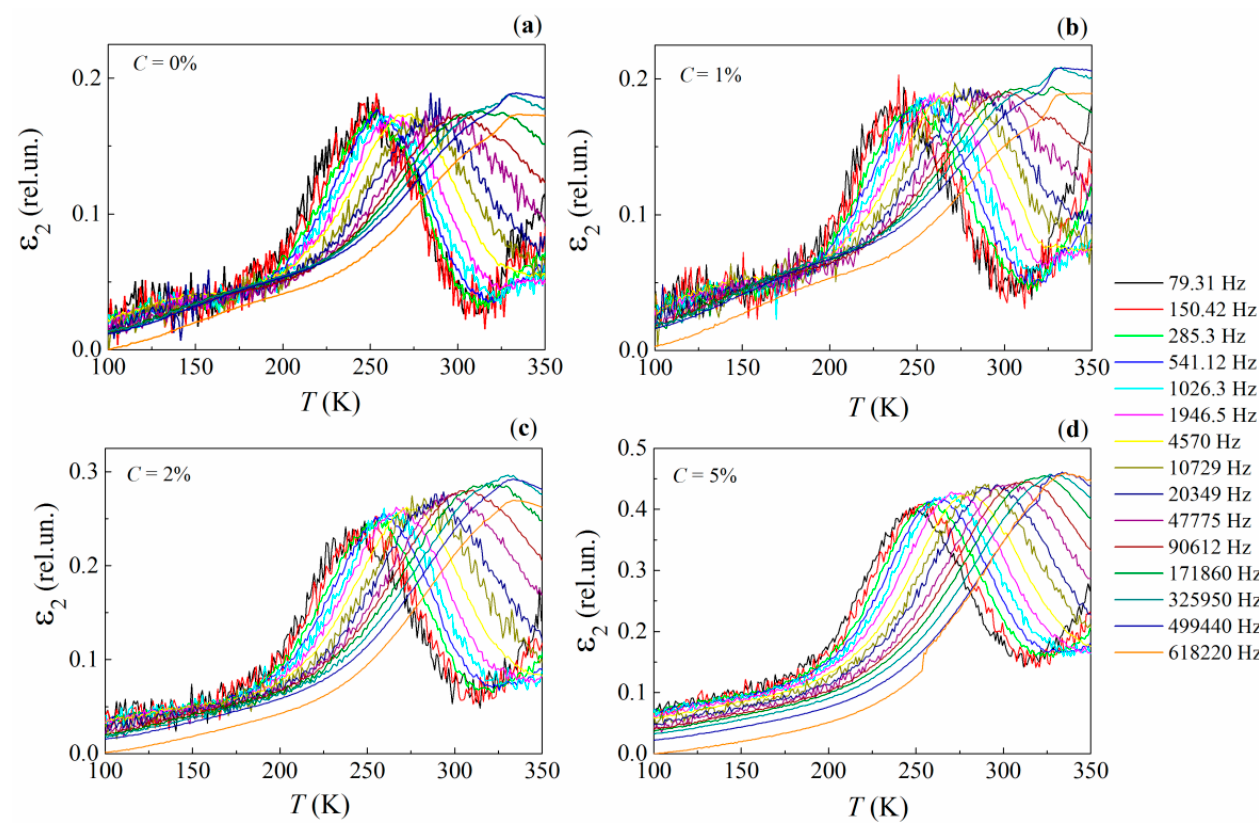
Figure 13. Temperature dependences of the relative dielectric loss factor ( ε 2 ) at fixed frequencies for the neat epoxy ( a ) and its MLG composites of 1% ( b ), 2% ( c ), and 5% ( d ) graphene particles. Fixed frequencies (in Hz) are 79.31, 150.42, 285.3, 541.12, 1026.3, 1946.5, 4570.0, 10729.0, 20349.0, 47775.0, 90612.0, 171860.0, 325950.0, 449440.0, and 618220.0.